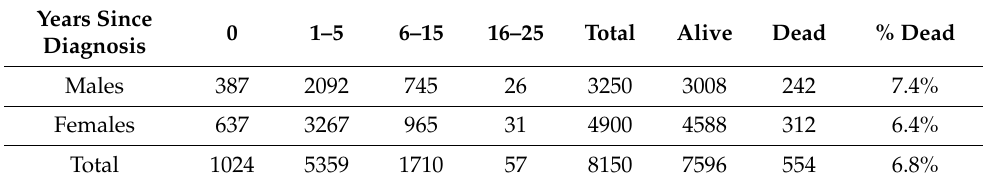
Table 2. Distribution of cases selected for the analysis, by sex, time elapsed since diagnosis, and life